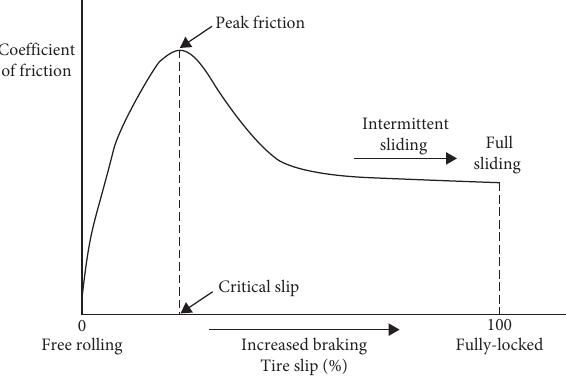
Figure 5: Pavement longitudinal friction versus slip